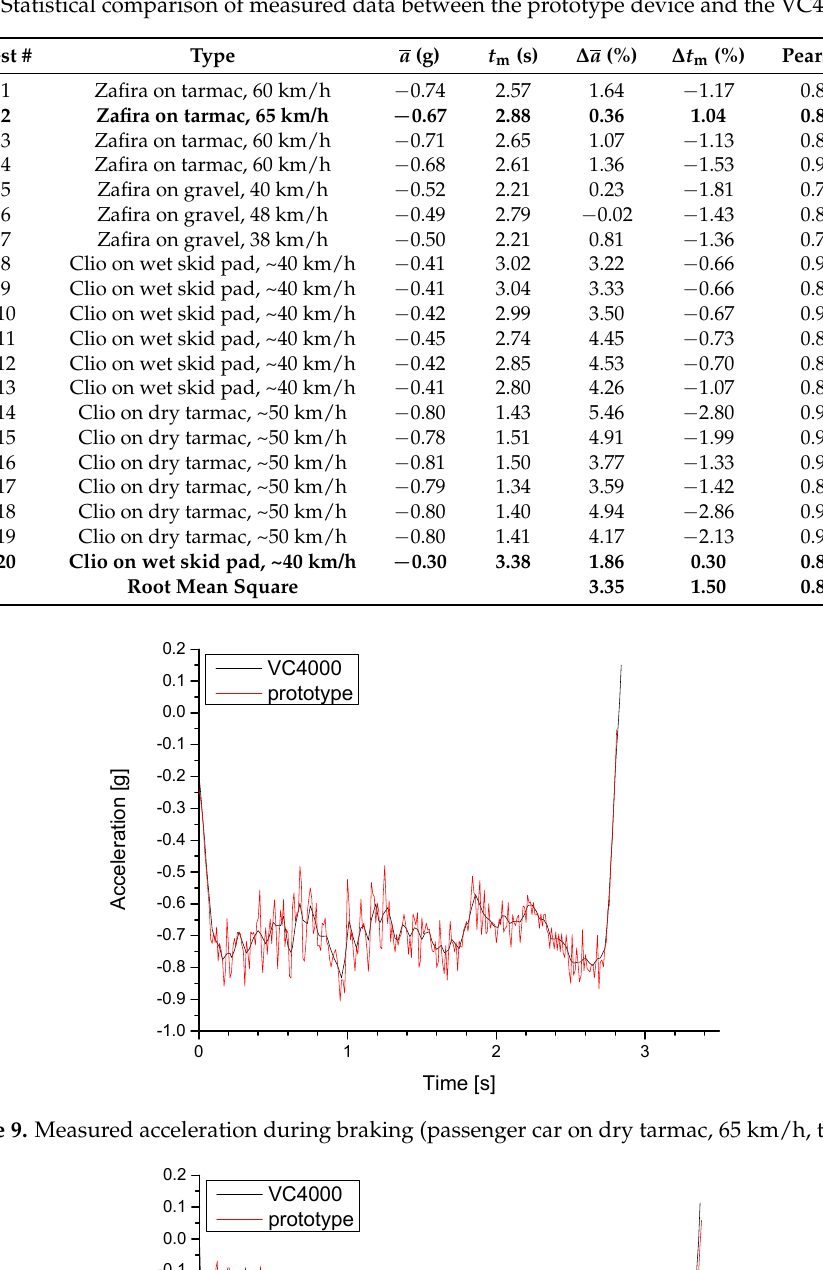
Table 5. Statistical comparison of measured data between the prototype device and the VC4000DAQ.